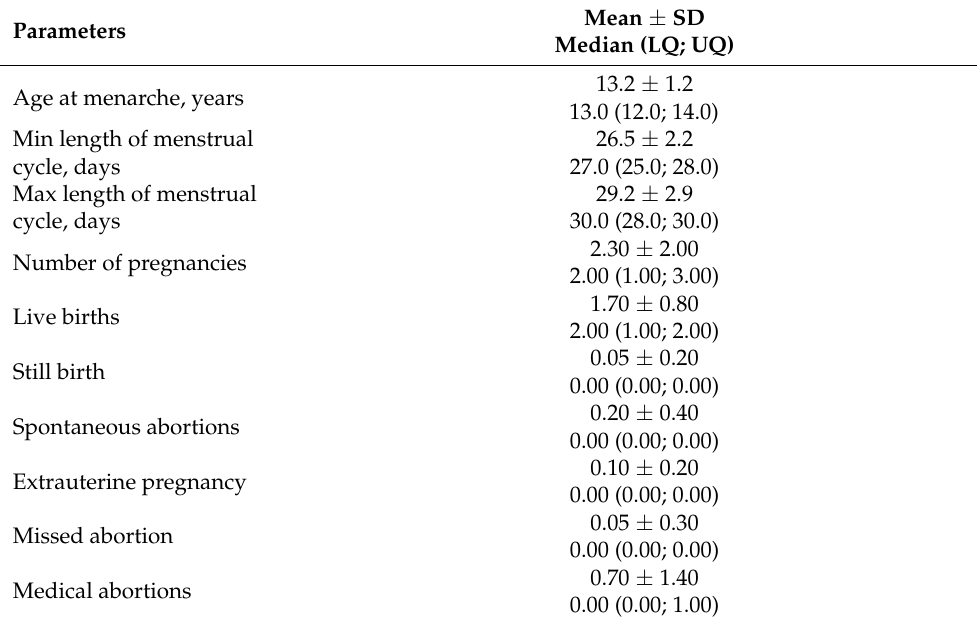
Table 2. Menstrual and reproductive history of healthy